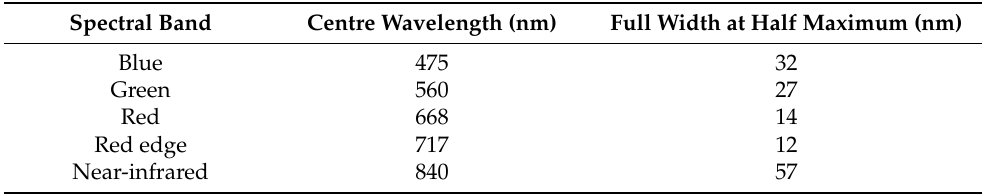
Table 1. Spectral characteristics of the MicaSense RedEdge-MX camera used for multispectral images acquisitions.